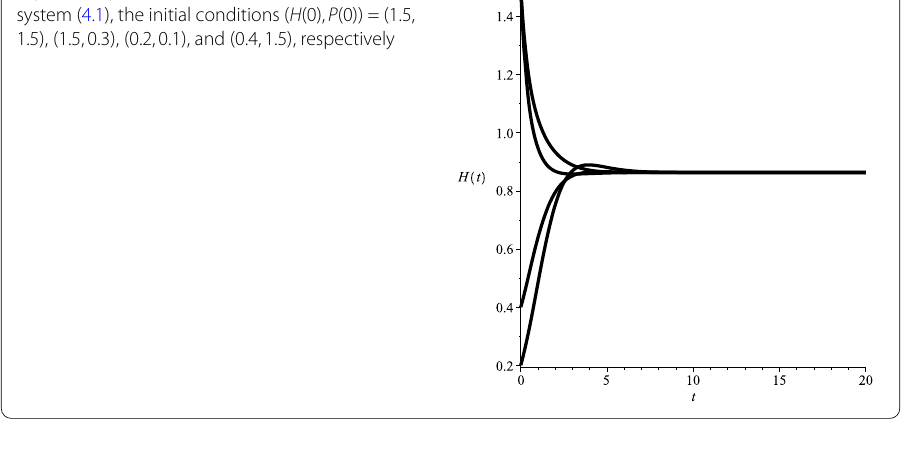
Figure 2 Dynamic behaviors of the second species in system (4.1), the initial conditions ( H (0), P(0))=(1.5,1.5), (1.5,0.3), (0.2,0.1), and (0.4,1.5),